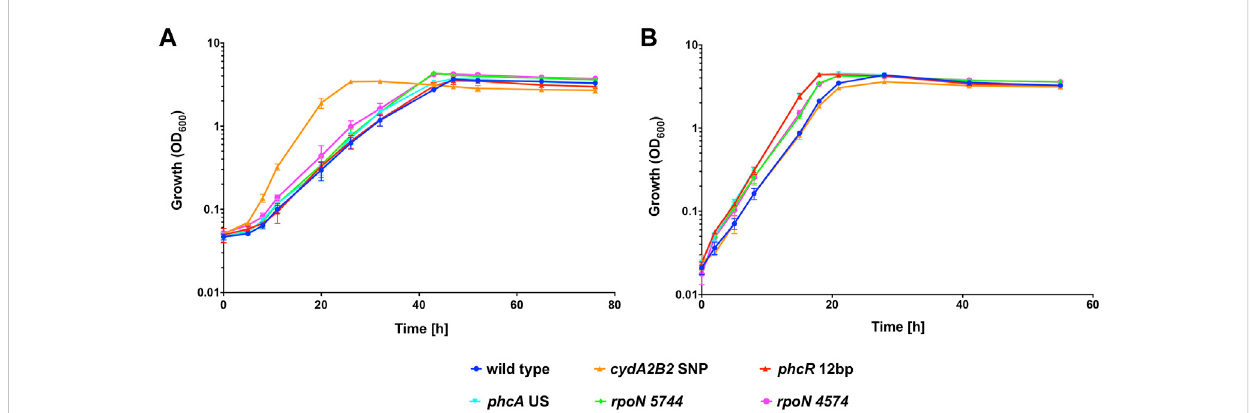
FIGURE 3 Heterotrophic growth of C. necator H16 and its single knock-in mutant derivatives in the presence of CO. Cultures were grown at 30 ° C in 20 mL F-MM contained in 150 mL serum bottles under a 2 bar atm of (A) 50% CO/50% air (v/v) or (B) 50% N 2 /50% air (v/v). Blue circles, wild type; orange triangles, C.necatorcydA2B2 SNP; red triangles, C.necatorphcR 12 bp; cyan triangles, C.necator phcA US; green diamonds, C.necatorrpoN 5744; pink circles, C. necator rpoN 4574. Error bars represent the standard deviation of the mean for three independent replicates.